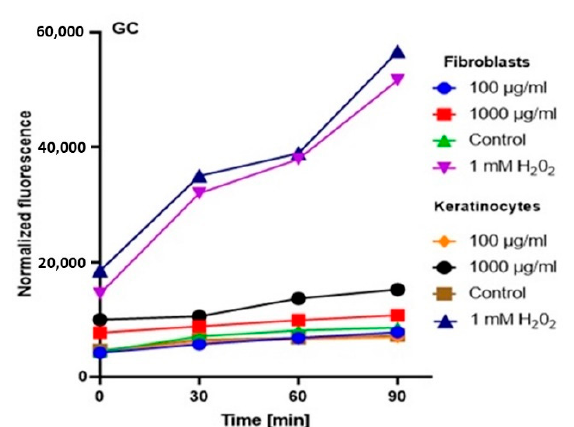
Figure 3. The effect of Green coffee extract on the DCF fluorescence in fibroblasts and HaCaT cells. The data are expressed as the mean ± SD of 3 independent experiments, each of which consisted of 3 replicates per treatment group.